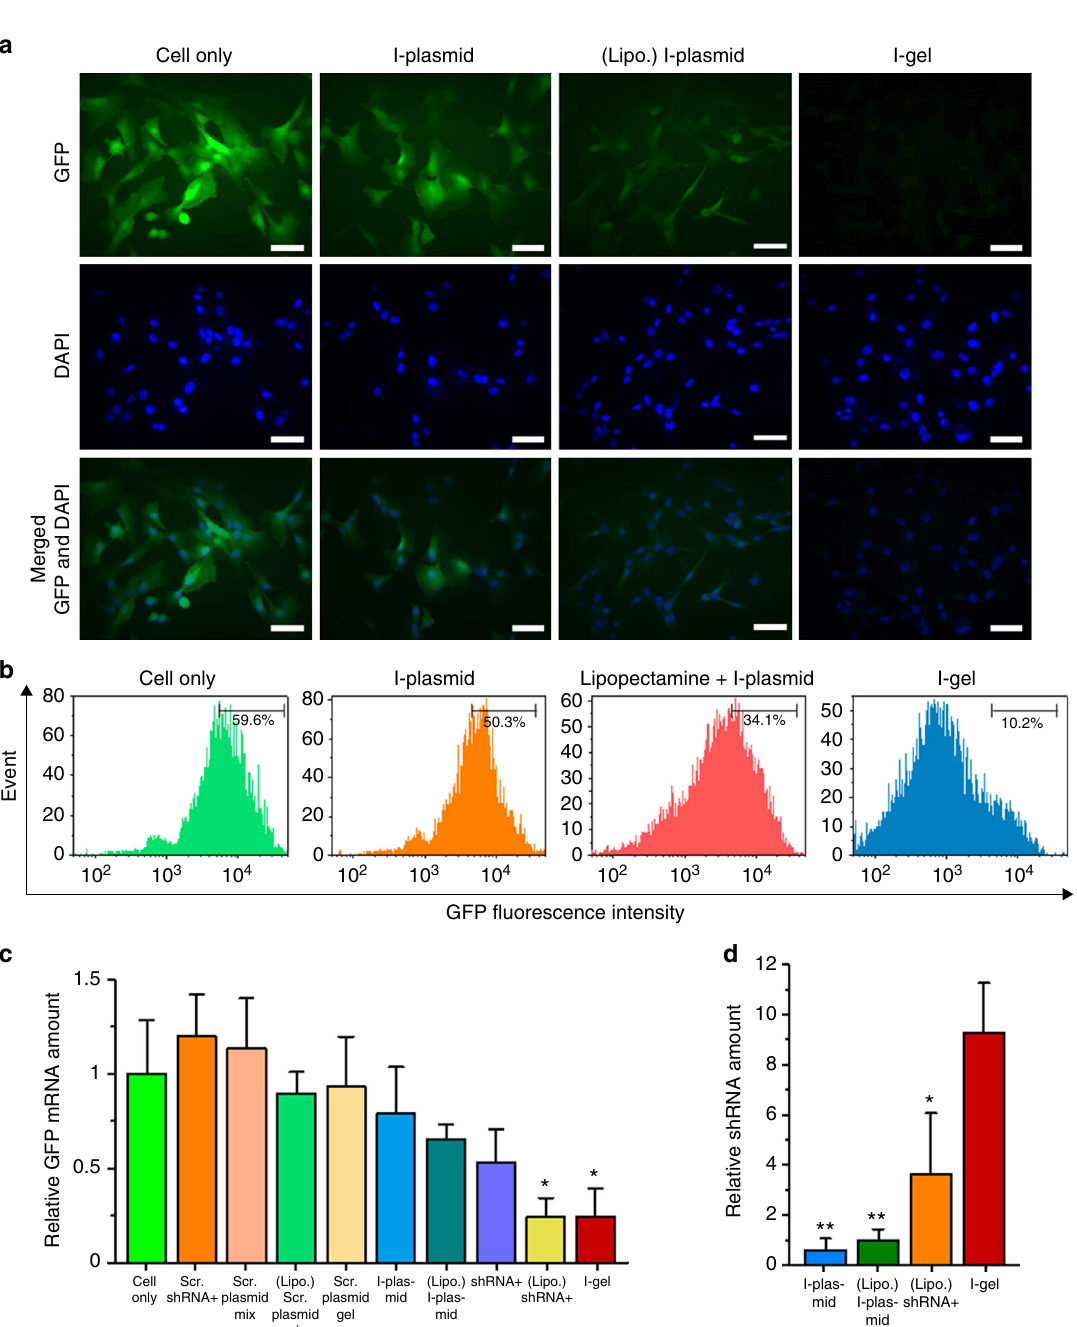
Fig. 5 Gene-silencing effect by I-gel i n a cellular level. a Fluorescence images of MDCK-GFP-expressing (MDCK-GFP) cells coincubated with I-plasmid, I- plasmid complexed with lipofectamine, and I-gel. Scale bar: 20 μ m. b Fluorescence-activated cell sorter analysis of GFP-expressing cell line, MDCK-GFP cells after treatment of sample/polymerase complexes in serum-de fi cient medium. The number means the percentage of GFP-overexpressing cells sorted within a pre fi xed gate region as indicated by a bar. c , d The relative amounts of ( c ) GFP mRNA and ( d ) shRNA from GFP-expressing MDCK cells after incubation in various conditions. ( † concentration of these conditions were 102-fold increased in consideration of the template to RNA transcription rate of the I-gel) ( c : * P < 0.05, analyzed by one-away ANOVA, followed by Holm – Bonferroni multiple comparisons post test. Asterisks indicate statistically signi fi cant differences between between each condition and Cell-only) ( d : * P < 0.05 and ** P < 0.005, analyzed by t test. Asterisks indicate statistically signi fi cant differences between each condition and I-gel). Error bars refer to standard deviations from three ( c ) or six ( d )